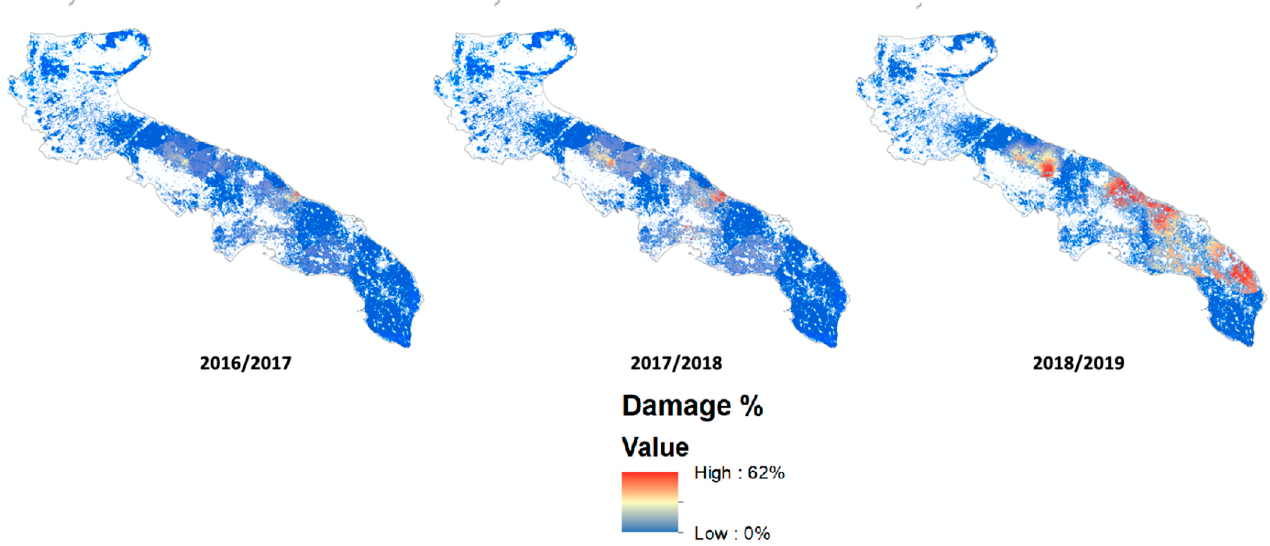
Figure 5. Distribution of damaged areas resulting from kriging interpolation. Areas over 30% damage are identified in red.